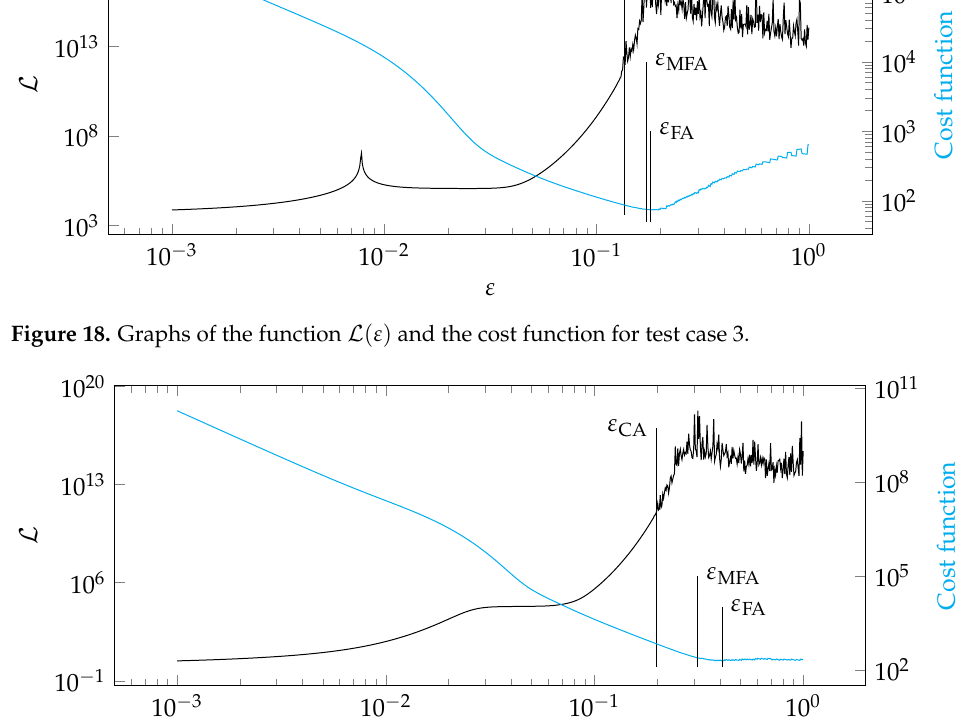
Figure 19. Graphs of the function L ( ε ) and the cost function for test case